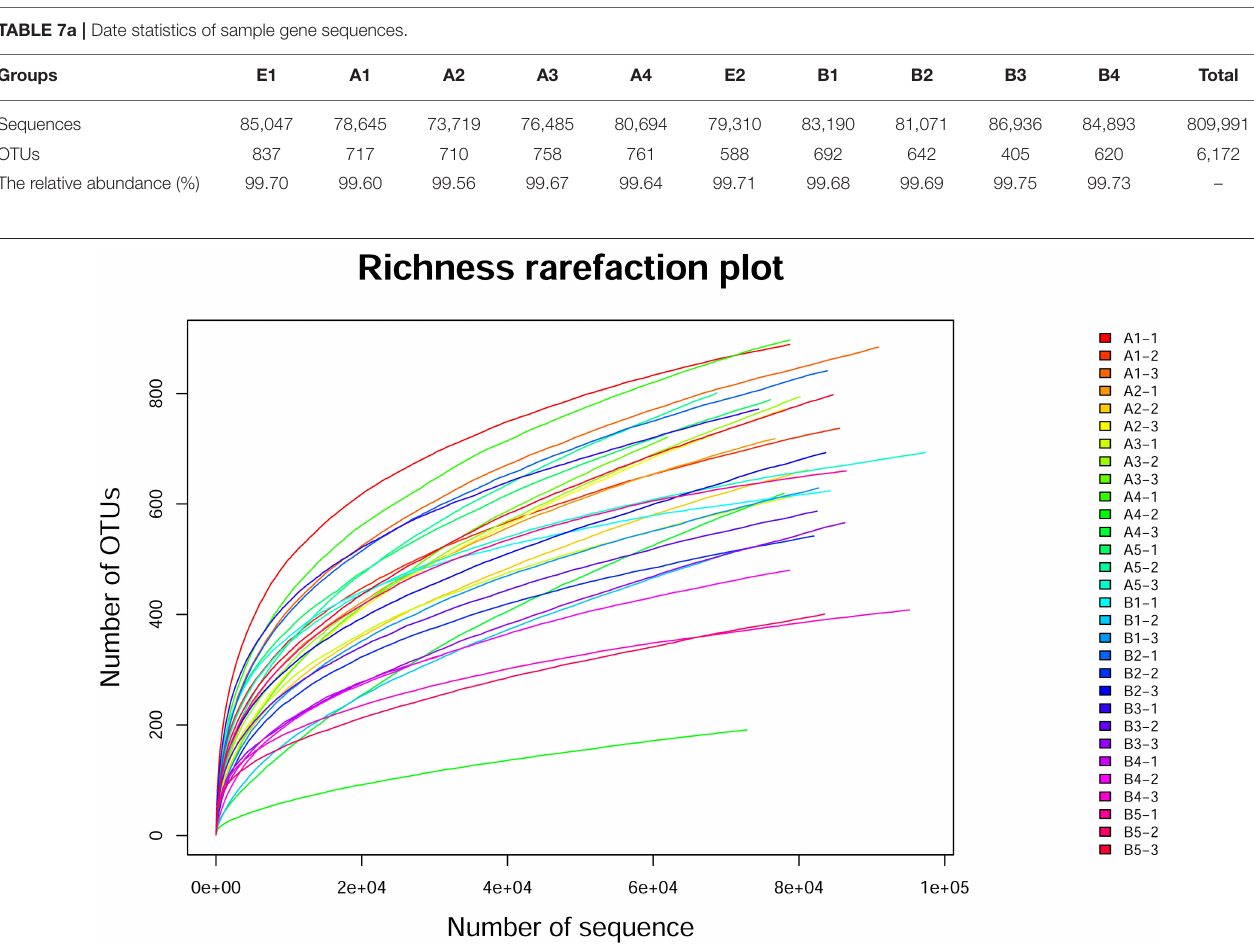
FIGURE 2 | Alpha exponential dilution curve. The dilution curve was drawn with the number of sequences sequenced (as generated by random sampling) as the abscissa and its corresponding OTU number based on 97% sequence similarity as the ordinate. The dilution curve was infinitely close to the maximum number of OTUs contained in the sample, but species abundance differed between samples. All curves flattened and approached a